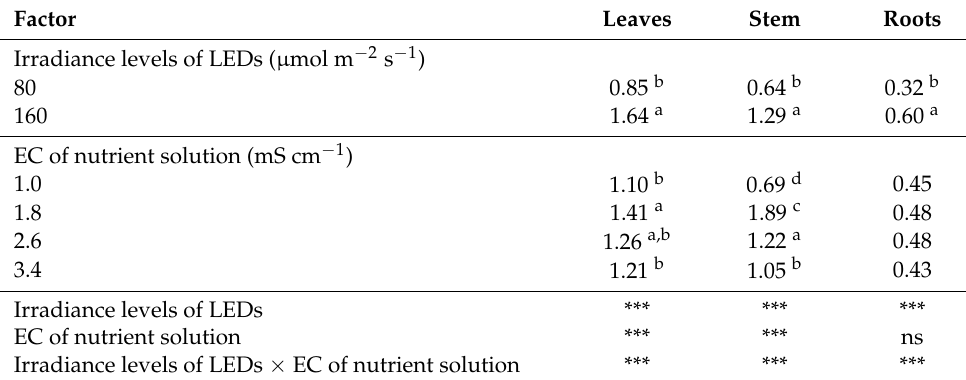
Table 3. Effects of LED irradiance levels and nutrient solution EC on the dry weight (g) of three different parts (leaves, stem, and roots) of lemon